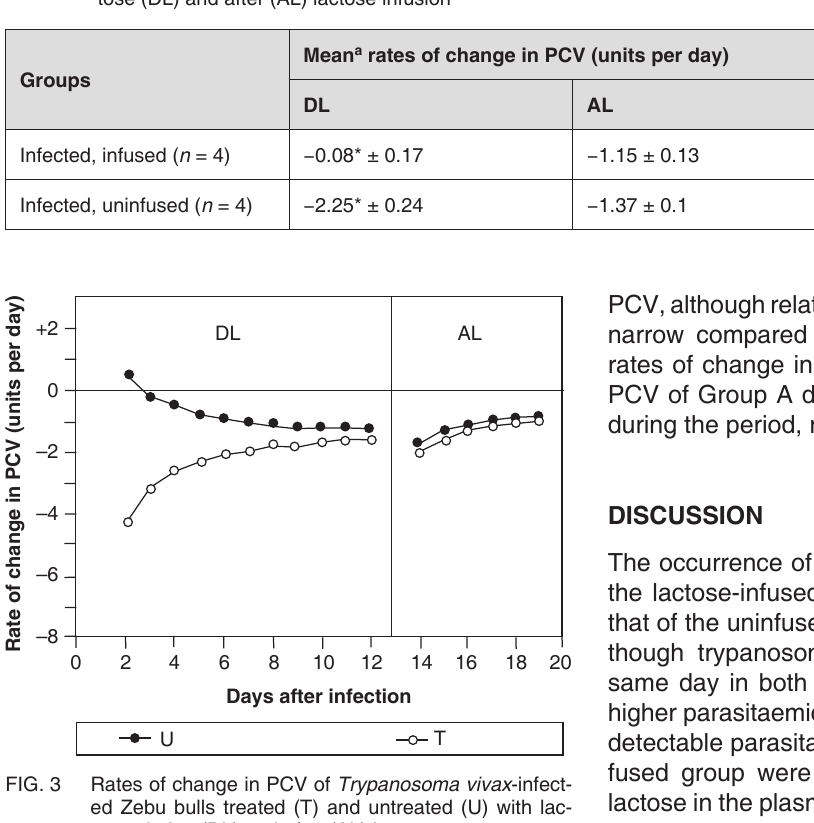
FIG. 3 Rates of change in PCV of Trypanosoma vivax -infect- ed Zebu bulls treated (T) and untreated (U) with lac- tose, during (DL) and after (AL)